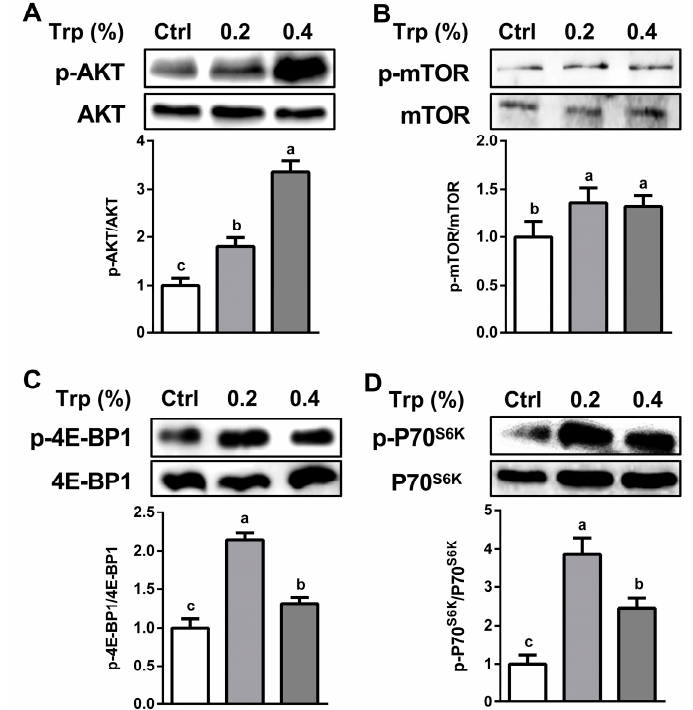
Figure 3. Dietary supplementation with Trp activated the mTOR signaling pathway in the jejunum of weaned piglets. Protein abundances of AKT ( A ), p-mTOR ( B ), p-4E-BP1 ( C ), and p-P70 S6K ( D ) were determined. Values are means ± SEM, n = 6. Means without a common letter differ, p < 0.05. Ctrl, the control group (% Trp).